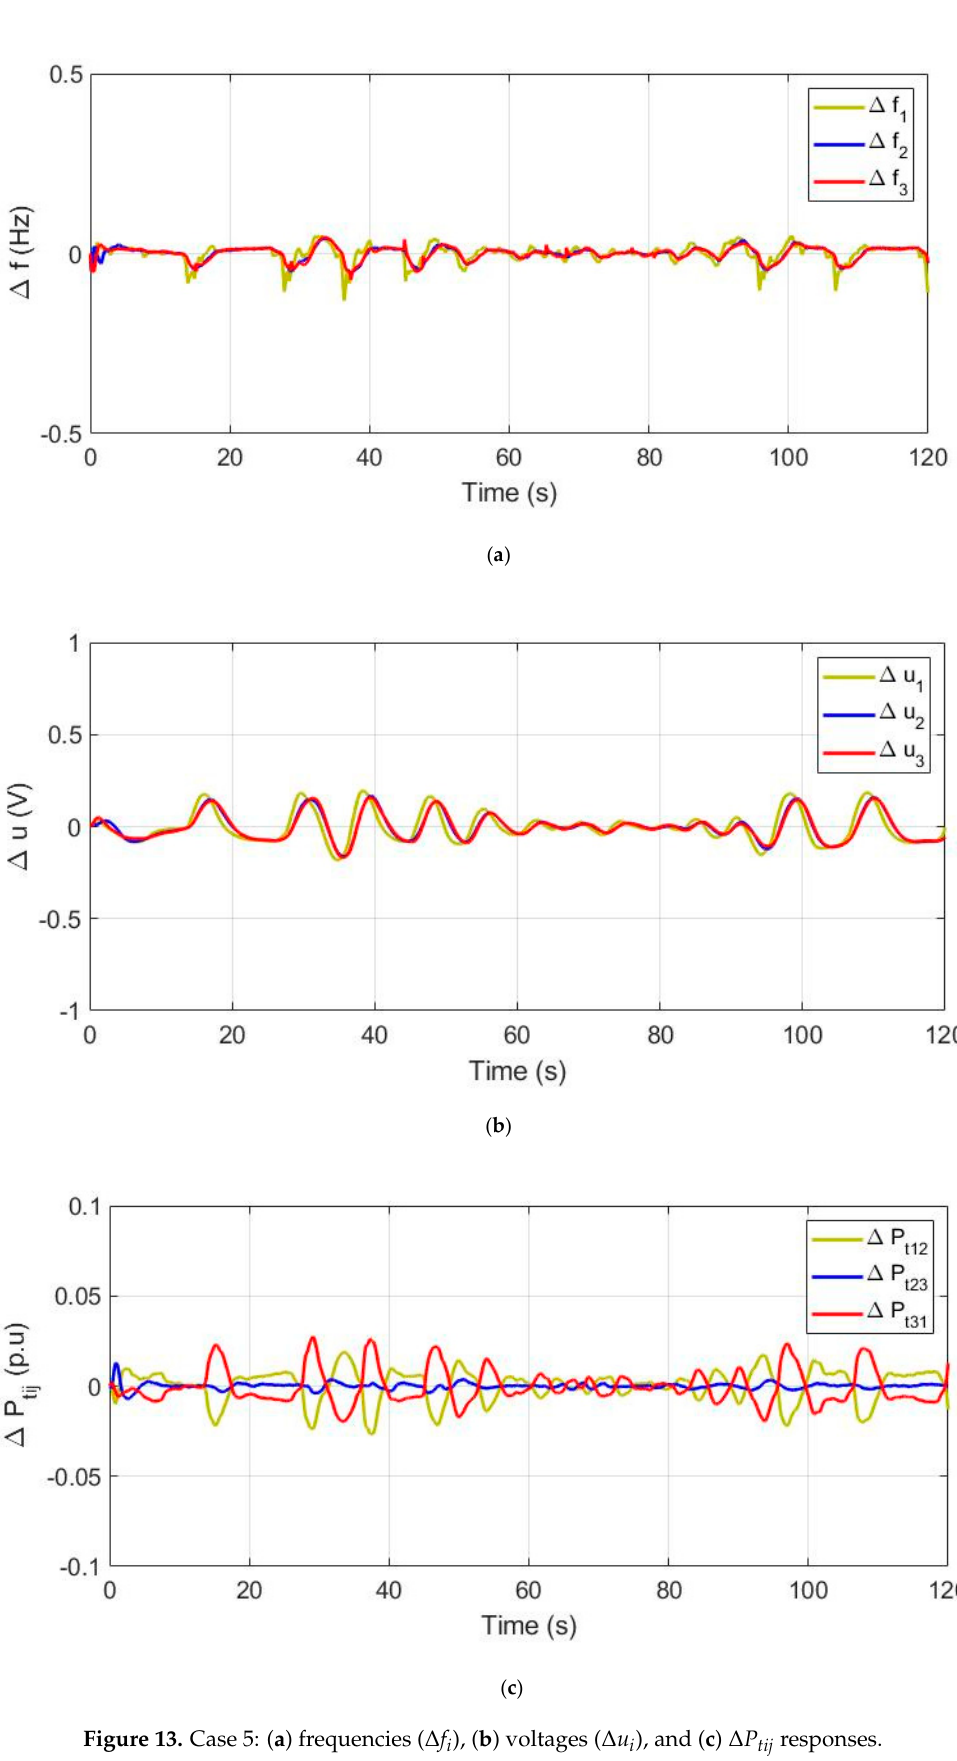
Figure 13. Case 5: ( a ) frequencies ( Δ f i ), ( b ) voltages ( Δ u i ), and ( c ) Δ P tij responses.